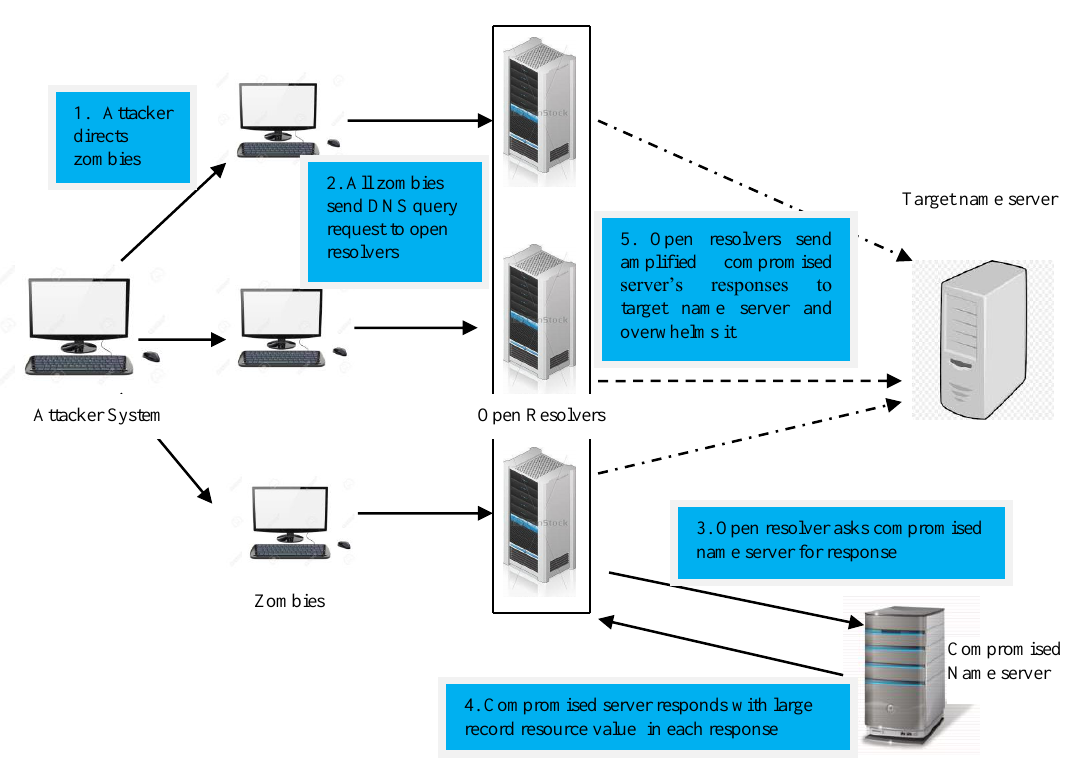
Figure 2. DNS reflection and amplification DDoS